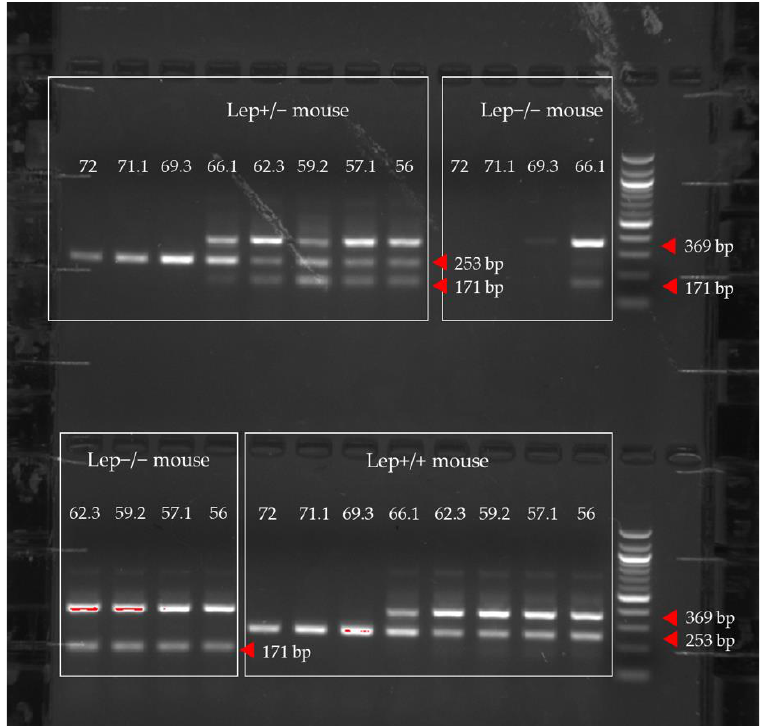
Figure 2. DNA samples collected from wildtype (Lep+/+), heterozygous (Lep+/ − ), and ob / ob mice (Lep − / − ) were analyzed in a gradient tetra-primer ARMS-PCR (from 56 °C to 72 °C) to identify an optimal TA for the assay. Quick-Load ® 100 bp DNA Ladder (New England Biolabs, Ipswich, MA) was used as the reference to facilitate the visualization of the positions of the amplicons on the 1.5% agarose gel. Red arrows correspond to the different sizes of PCR amplicons on the gel.